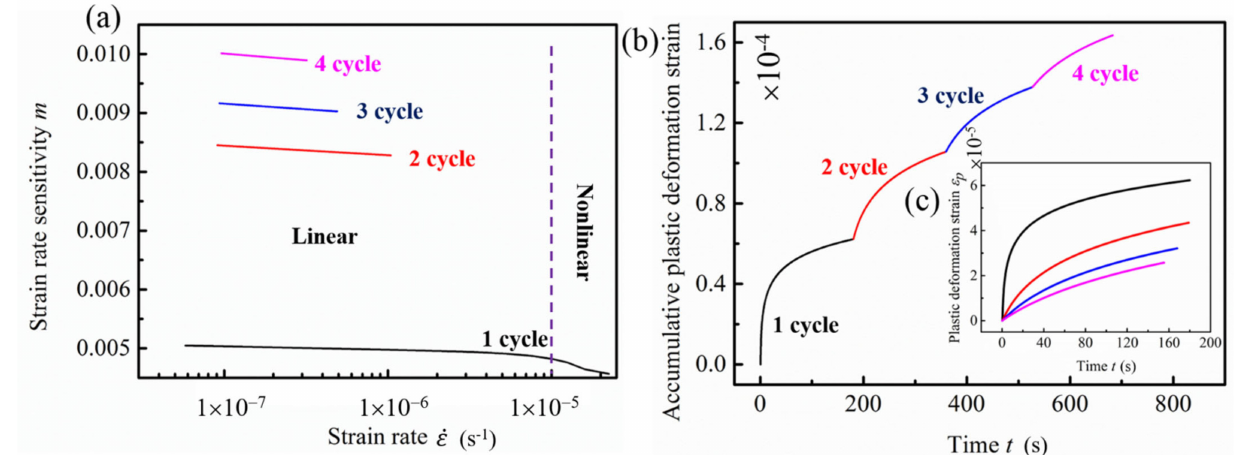
Figure 6. ( a ) Strain rate sensitivity at each cycle calculated according to Equation (13); ( b ) the accumulative plastic deformation strain during the stress relaxation test; ( c ) the plastic deformation strain at each cycle; the same color represents the same cycle as ( b ).